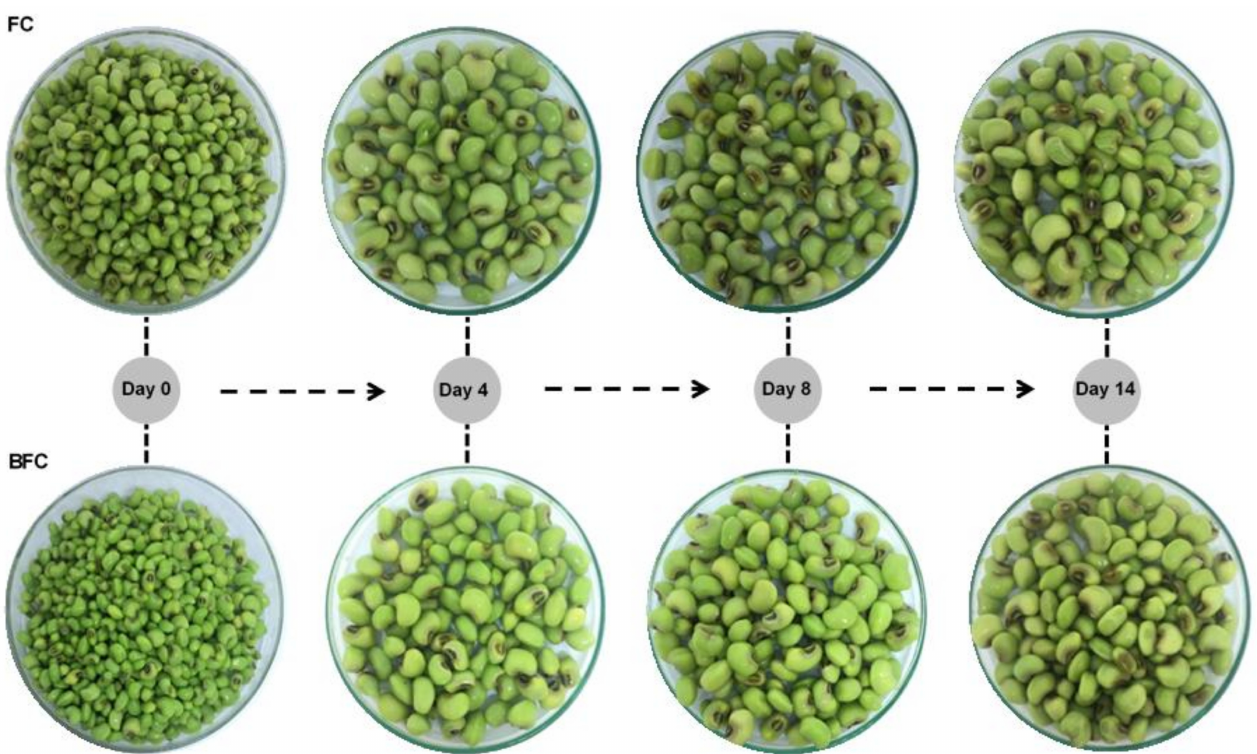
Figure 5. Photographic monitoring of senescence stage of fresh cowpeas (FC) and blanched fresh cowpeas (BFC) stored under refrigeration.